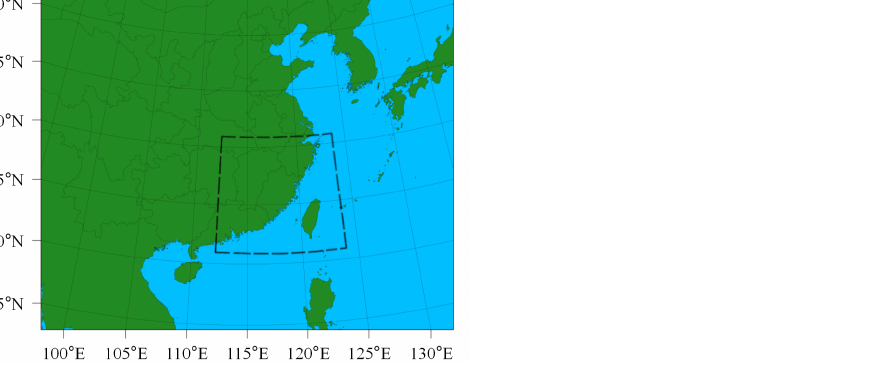
Figure 1. Schematic diagram of the location of the dataset. The area within the dotted line is the spatial range of the dataset. Table 1. The parameter information of the three types of data. The original time resolution of the radar echo data is 6 min.